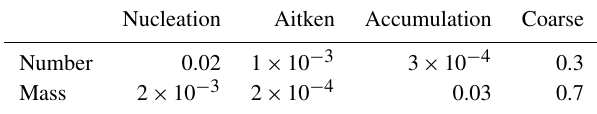
Table 2. Below-cloud scavenging efficiency factors used in the wet deposition scheme. Values are adapted from Croft et al.